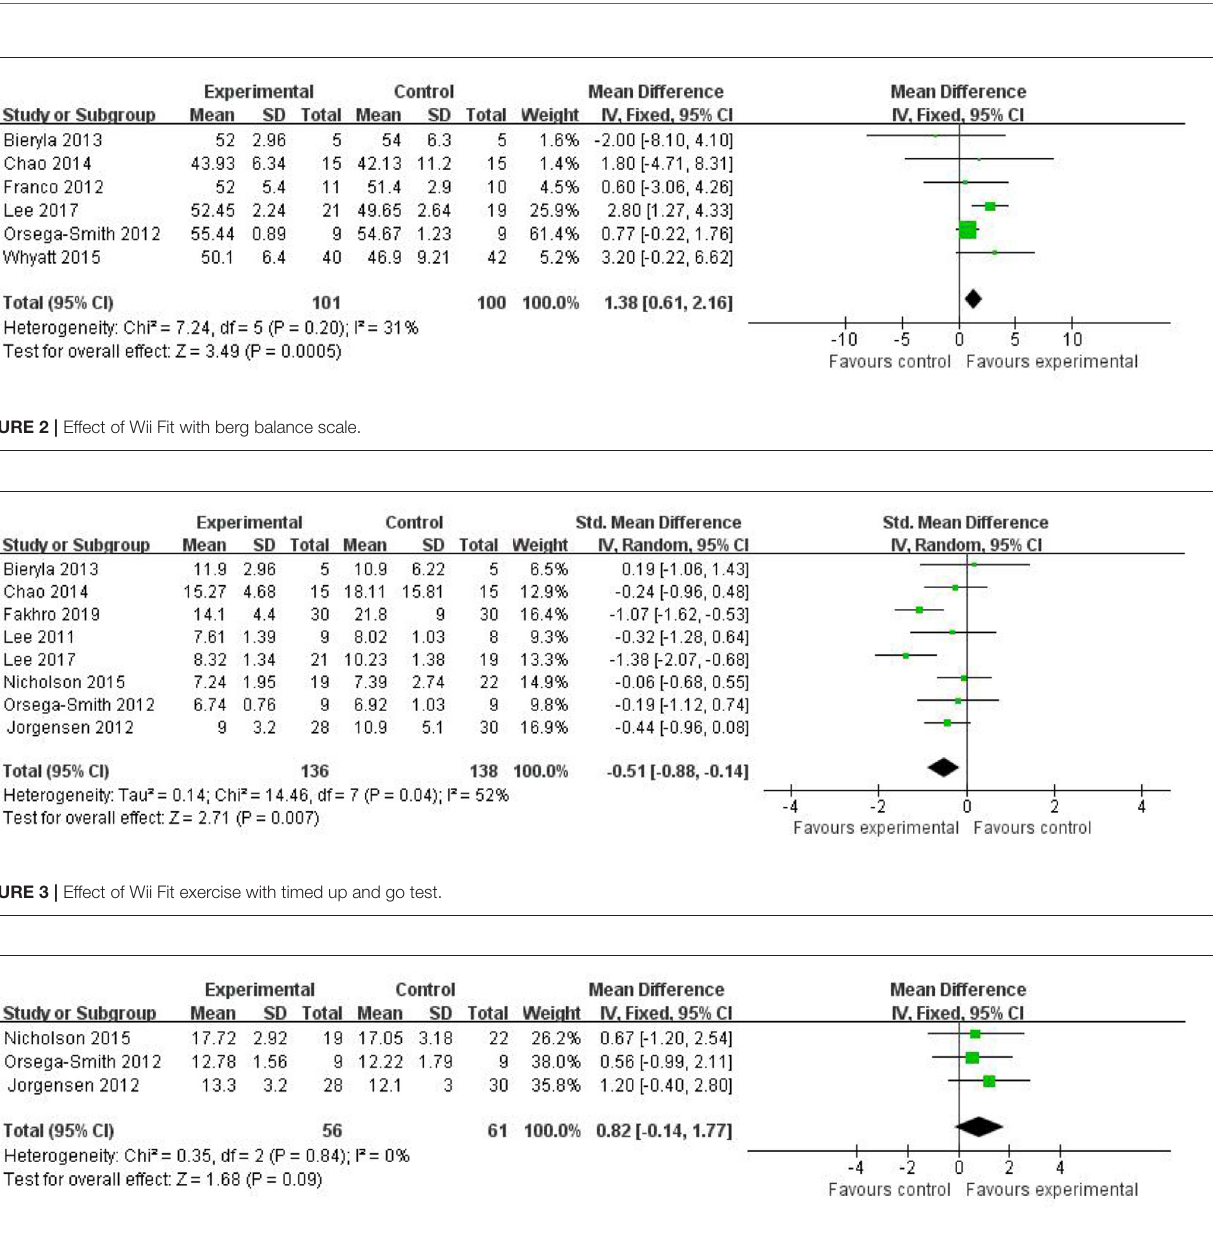
FIGURE 4 | Effect of Wii Fit exercise with 30-s chair stand